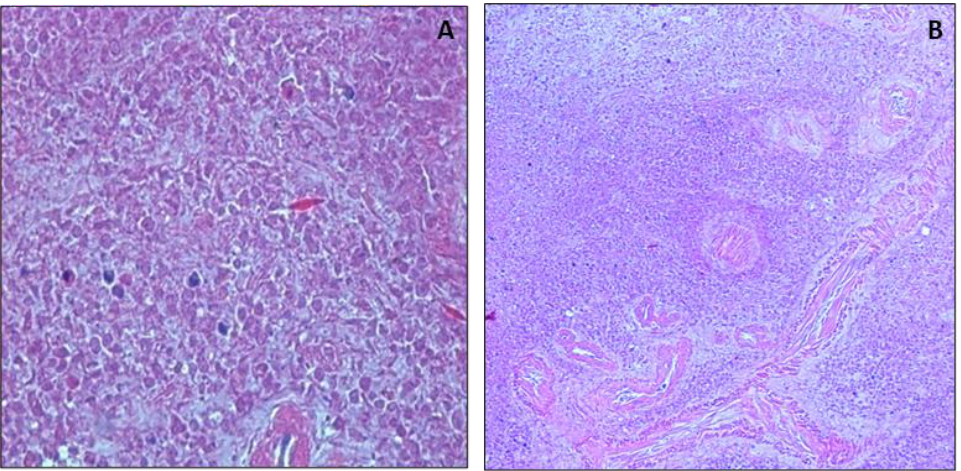
Figure 4. Morphological analysis of spleen. ( A ) Image displays well preserved spleen 5 days after death, 10×. ( B ) Image shows altered spleen parenchyma 15 days after death, 10×.